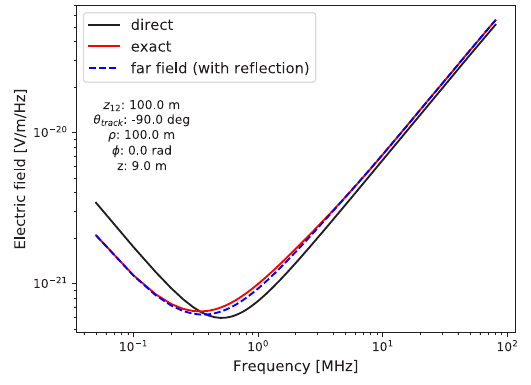
Figure 4. Same as Fig. 4, but with the track at a height of 100